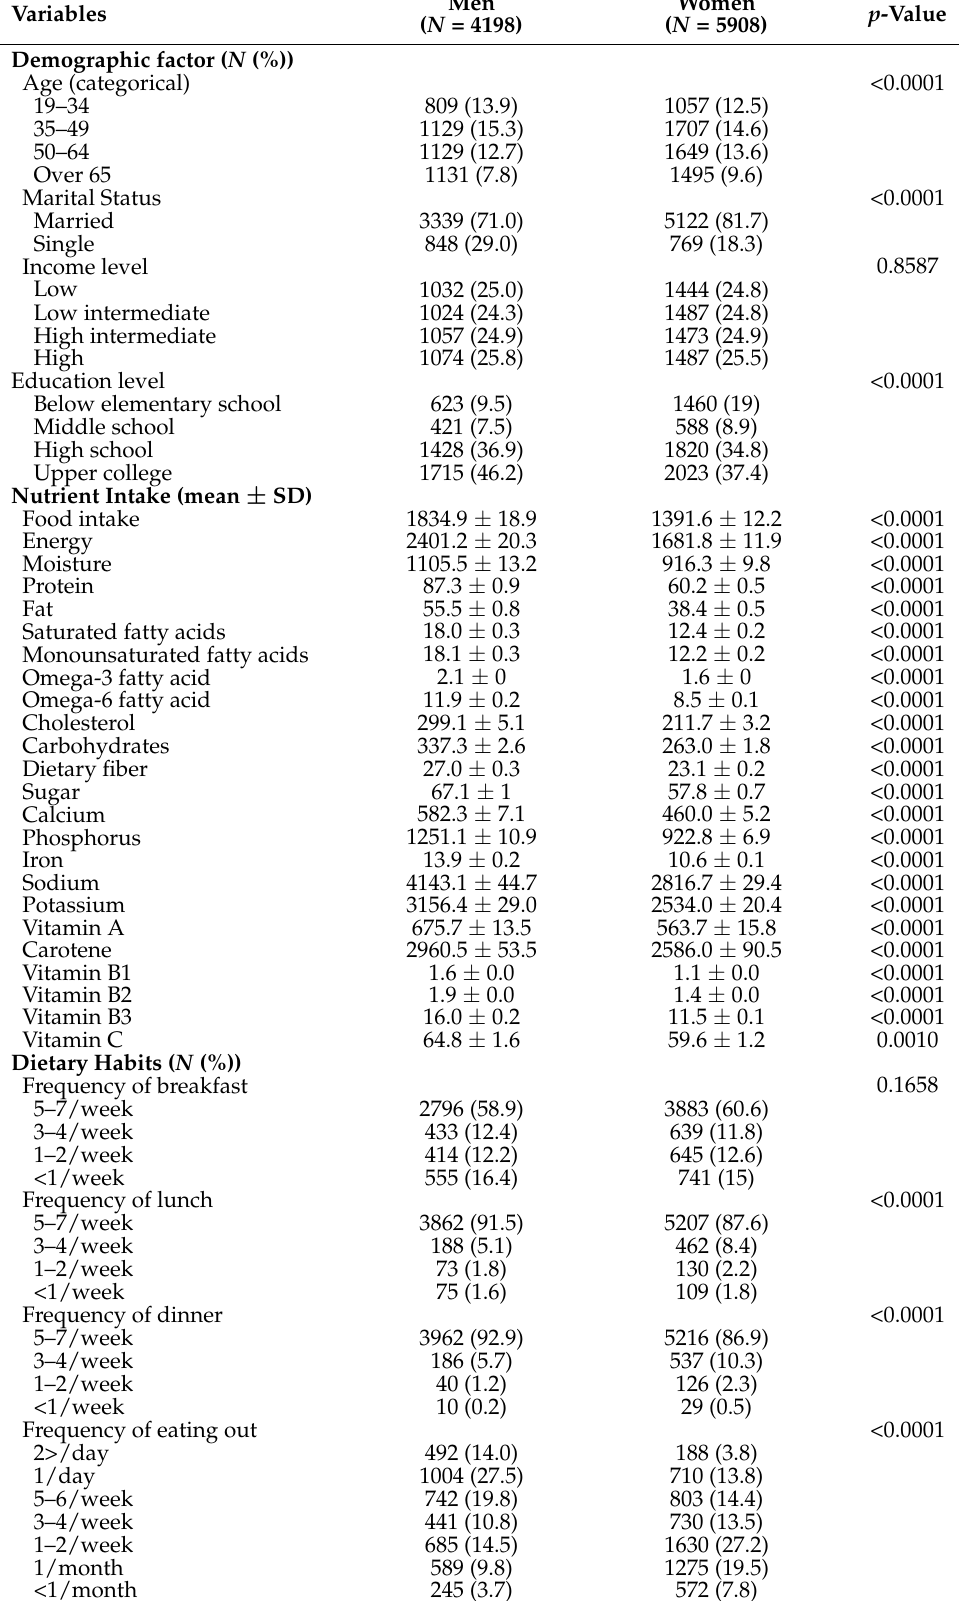
Table 1. Basic characteristics of the study